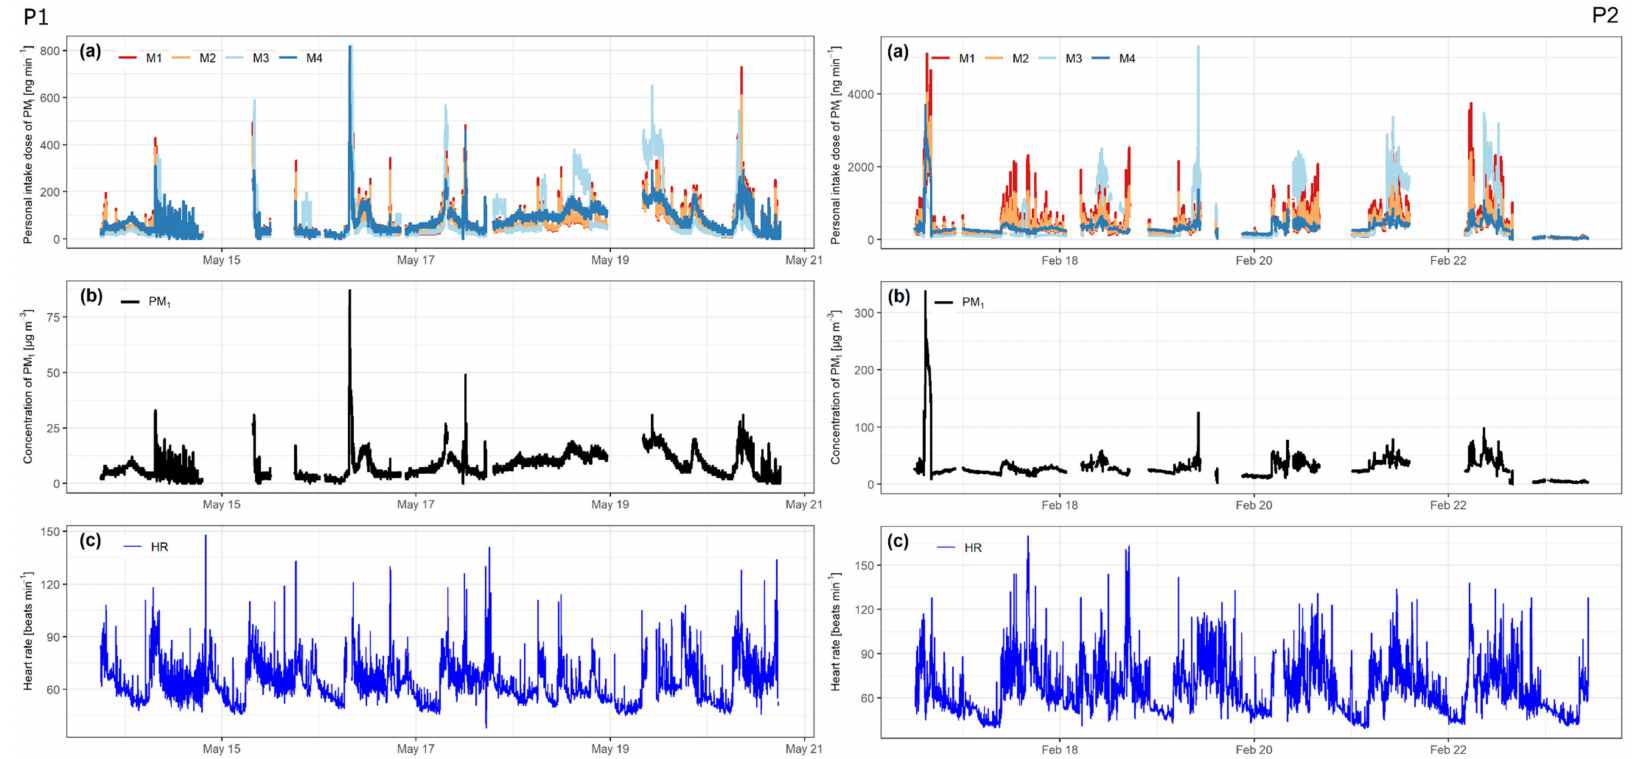
Figure 2. ( a ) Calculated intake dose of PM 1 for all four models, ( b ) measured concentrations of PM 1 , and ( c ) heart rate in beats per minute. Left side for participant 1 (P1) and right side for participant 2